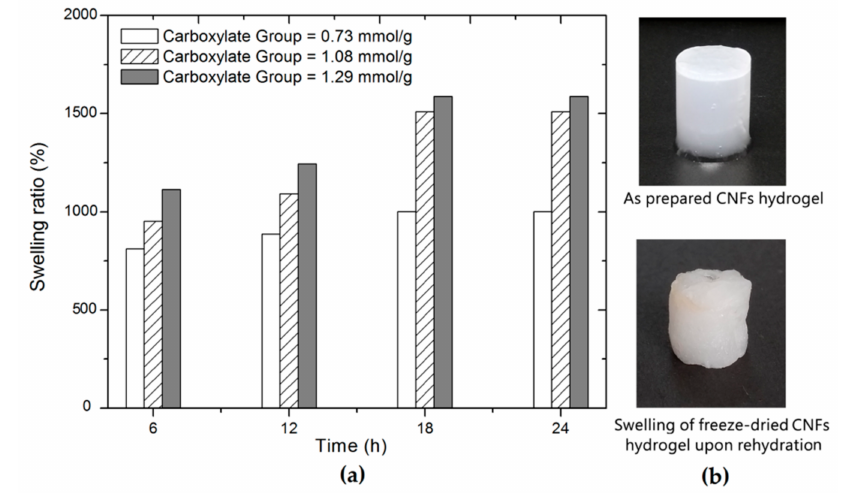
Figure 7. ( a ) Swelling ratio of CNFs hydrogels at a different soaking time; ( b ) visual appearance of a CNFs hydrogel prepared with TOCNFs of carboxylate group 1.29 mmol/g. The representative hydrogels were prepared at a fixed TOCNFs concentration of 3.0 wt.% and Zn 2+ concentration of 0.2